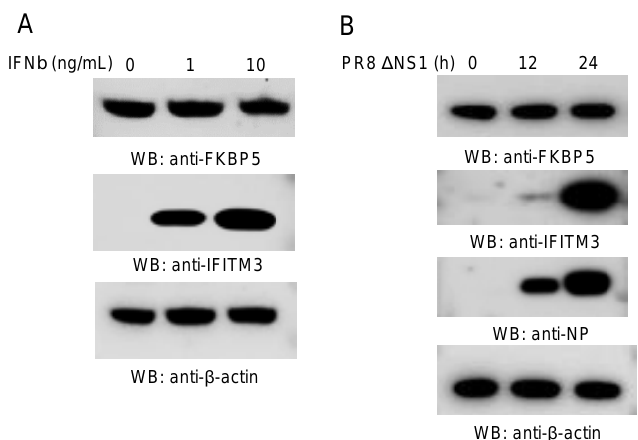
Figure 2. FKBP5 expression is not modulated by IFN and IAV. ( A ) A549 cells were treated with the designated amount of IFN β for 12 h. Cell lysates were blotted with the indicated antibodies. The interferon-induced transmembrane protein 3 (IFITM3) was included as a positive control. ( B ) A549 cells were infected with 1 MOI of PR8 ∆ NS1 IAV for 0 h, 12 h, and 24 h. Cell lysates were blotted with the indicated antibodies.